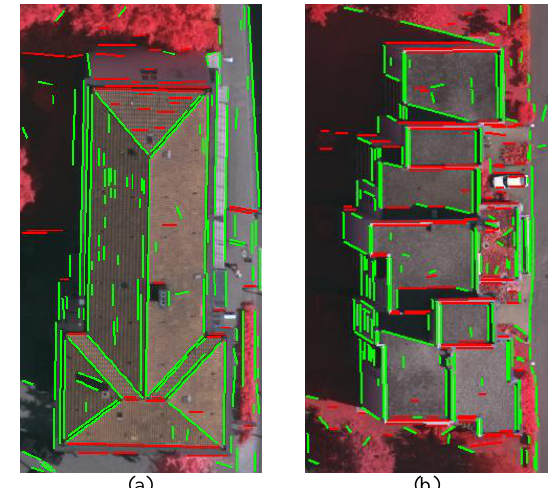
Fig. 1 Line segments extracted from test images. The red ones indicate the lines that are aligned (≤ 10º) with the epipolar